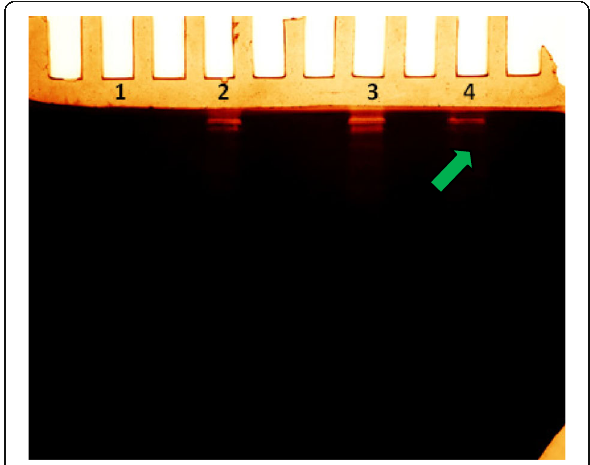
Fig. 7 Fibrinolytic activity of AiP1: Lane 1 is AiP1 treated with EDTA; lane 2 is SCF (2.5 μ g); lane 3 is SCF (5 μ g); lane 4 is AiP1 (2.5 μ g). Arrow indicates zone of fibrin digestion by AiP1AiP1 showed digestion of fibrin as observed by zones of substrate digestion in the